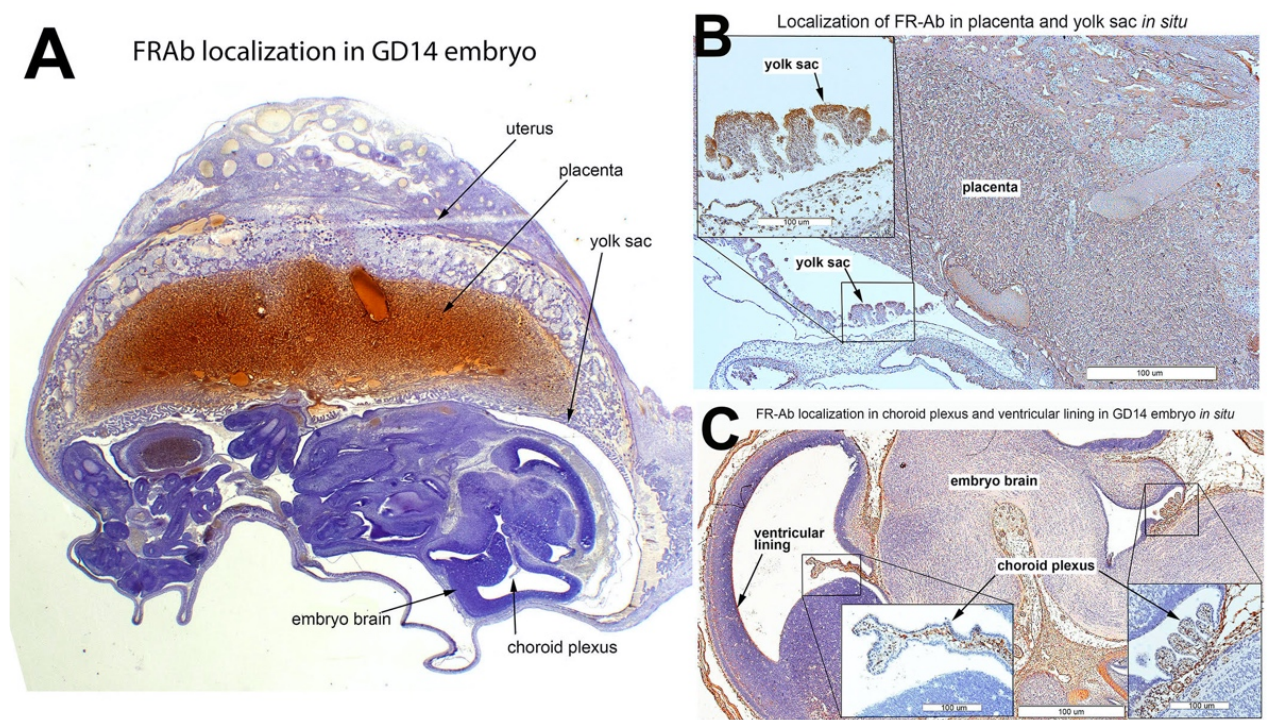
Figure 8. Distribution of IP-injected anti-rat FR α antibody (FR α Ab) in rat placenta and embryo on GD 14; accumulation of FR α Ab (brown staining) can be observed in the placenta and embryo ( A ); in the yolk sac ( B ) and in the choroid plexus, ventricular lining and in the brain tissue of the embryo ( C ). Hematoxylin (blue/purple staining) was used as a counterstain.